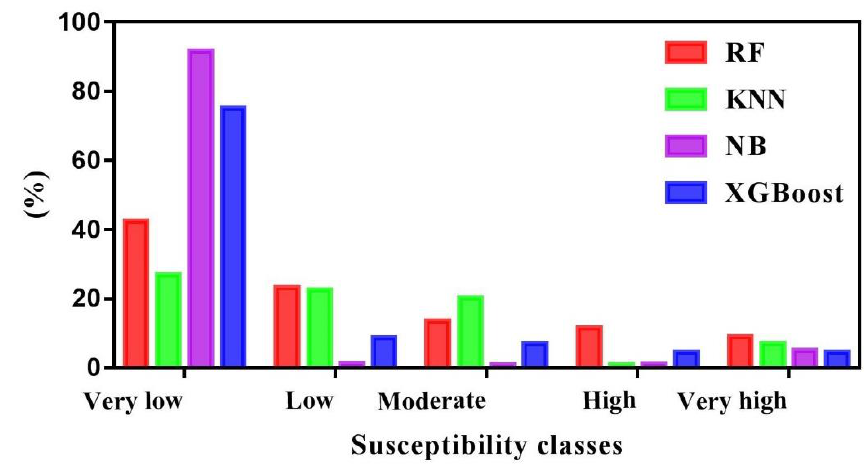
Figure 12. Percentages of the FFS classes.